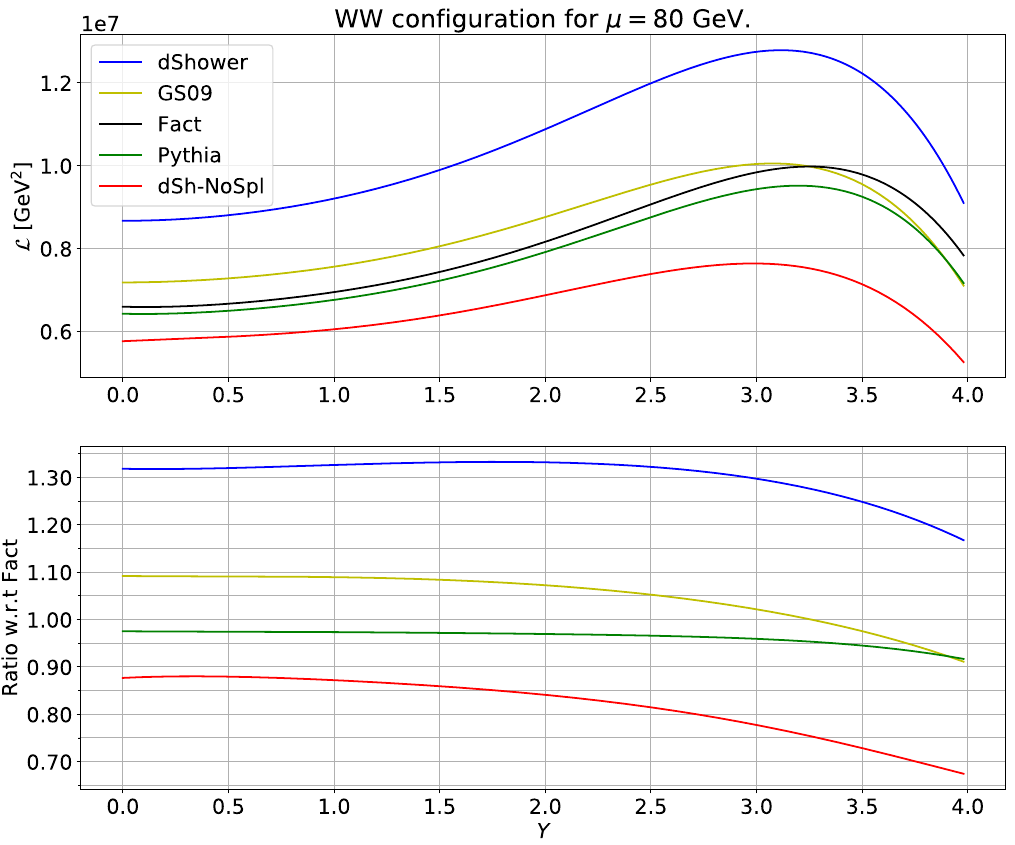
Figure 7 . ( Y ) for p s = 14 TeV and for di(cid:11)erent setups. The partonic con(cid:12)guration WW refers L to u (cid:22) d (cid:22) du + (cid:22) duu (cid:22) d + uu (cid:22) d (cid:22) d + (cid:22) d (cid:22) duu . The setup Fact is used as a reference in the ratio plot. Note the suppressed zero on the vertical